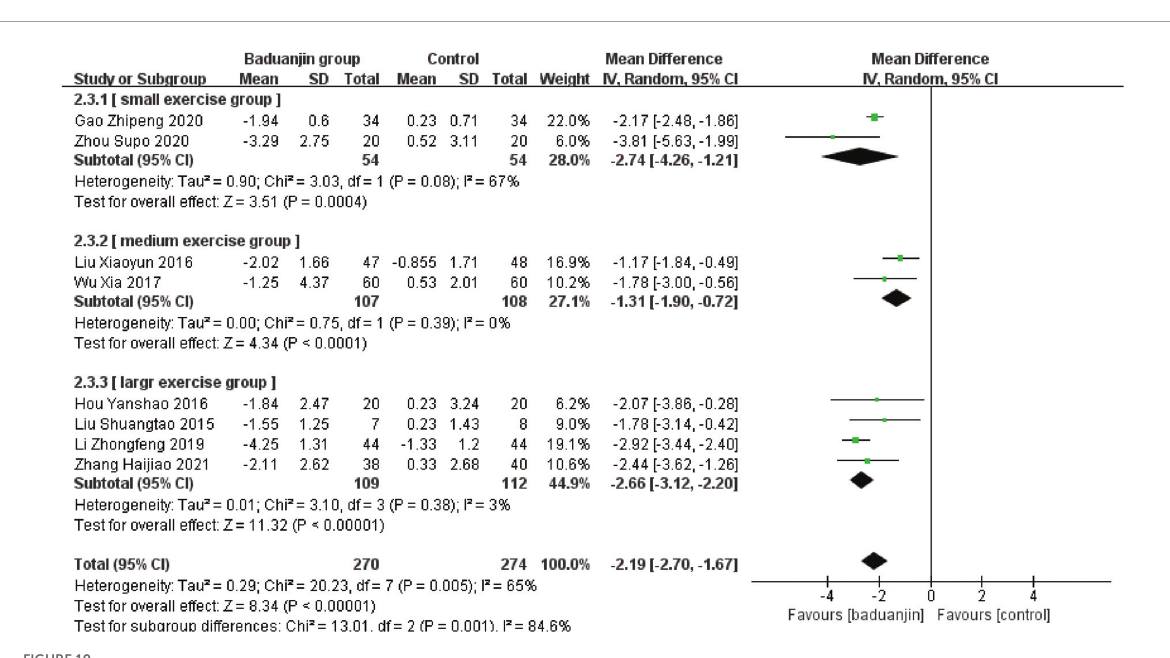
the evaluation standard for ECLSB is easily affected by external factors (32). Systematic evaluation of these three indicators in the present meta-analysis demonstrates